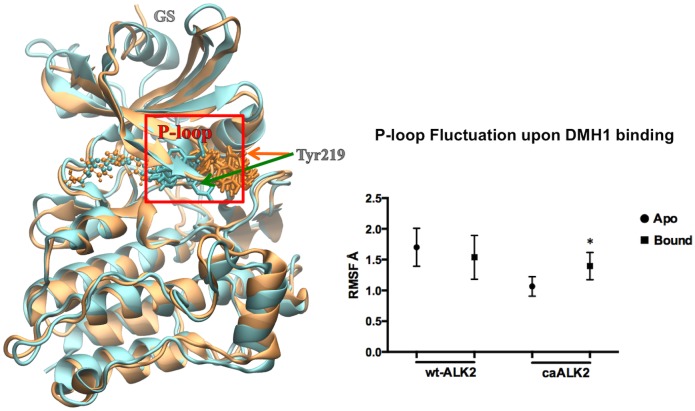

Left: Superposition of wtALK2 (cyan) and caALK2 (orange) backbone in cartoon. P-loop Tyr219 is shown in sticks with overlapped snapshots from the last 2 ns of simulation. DMH1 atoms are shown as small spheres. Right: RMSF of the P-loop in the unbound (apo) and DMH1 bound states. Statistical difference is represented by an * above the bound conformation; * = P < 0.05.